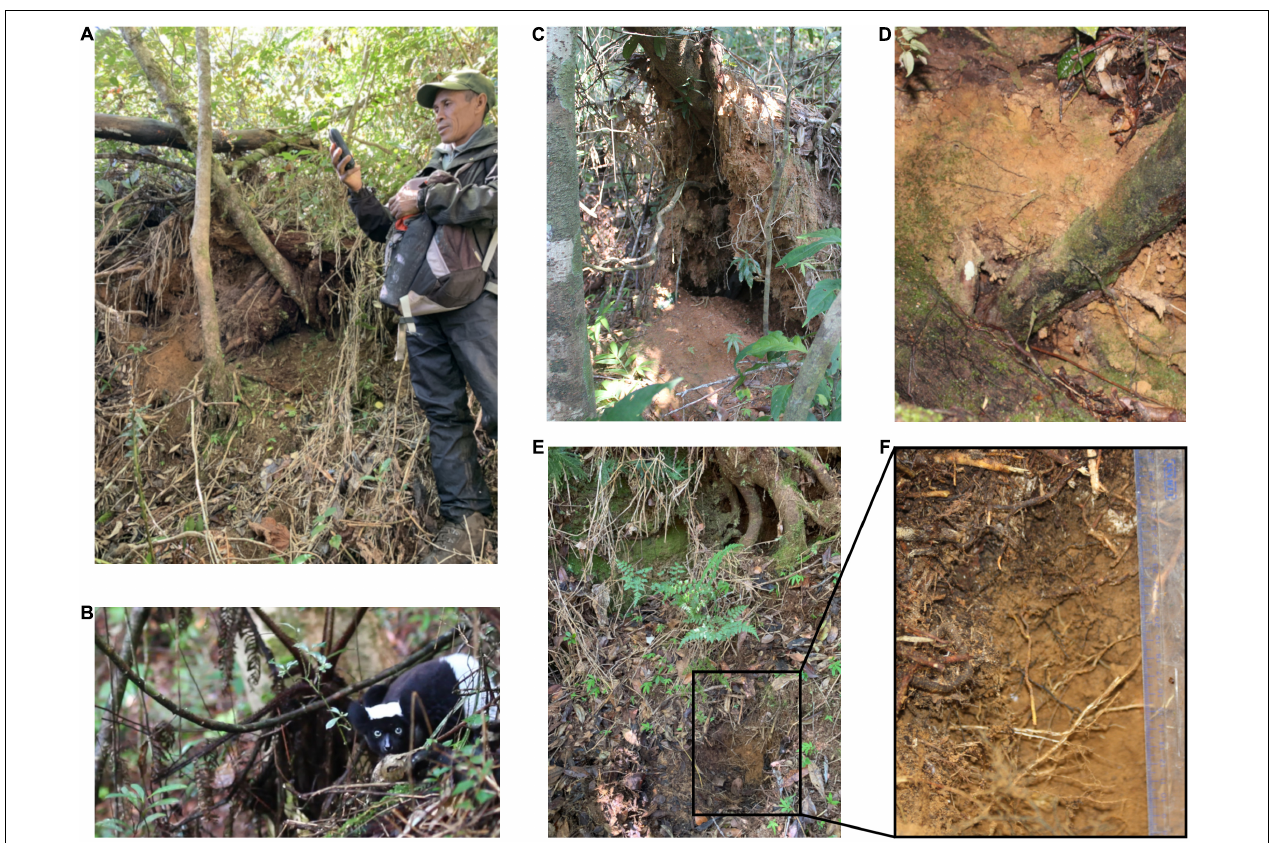
FIGURE 2 | Visualization of (A) a research guide recording the location of a geophagic site (GPS waypoint); (B) an indri ( Indri indri ) performing geophagic behavior, eating soil in a specific site; (C) a geophagic site under a fallen tree; (D) soil horizon eaten in the geophagic site; (E) a control site with the upper surface untouched; and (F) enlargement of the soil sampled in the control site, under the surface, in the horizon normally eaten by indri. Soil is collected free of debris (grass, leaves, stones,